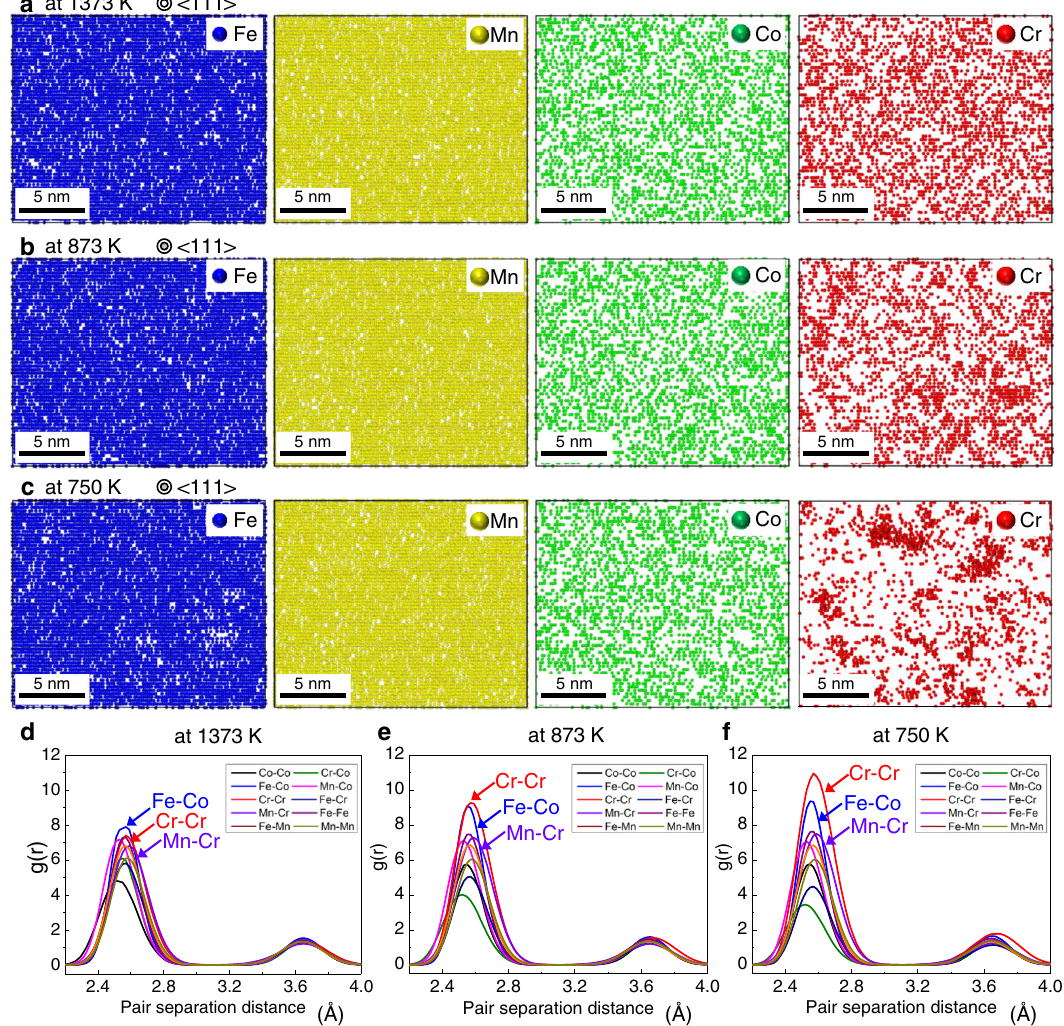
Fig. 1 | Atomistic MC simulations for CSRO domains in fcc-structured Fe 40 Mn 40 Co 10 Cr 10 (at%)HEAsystem.a Near-randomdistributionoffourprincipal elements obtained after the MC simulations at 1373K. A cell with 216000 atoms (15.7nm×13.6nm×12.8nm) was used for the simulation. b , c Non-random dis- tribution of principal elements showing thermally activated Cr-enriched like pairs andFe – Counlikepairsat873and750K,respectively,basedontheMCsimulations.